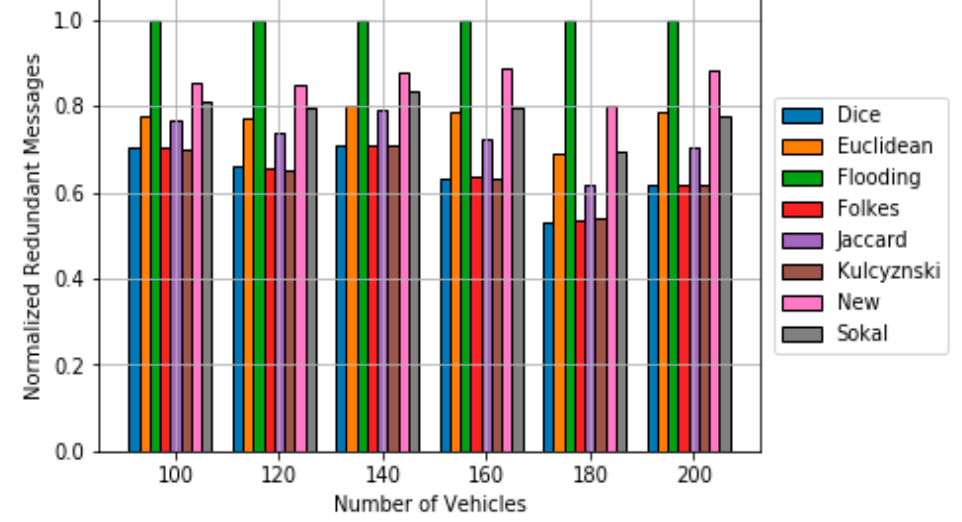
Figure 11. Comparison of redundancy results for the irresponsible scheme based on the different dissimilarity metric.